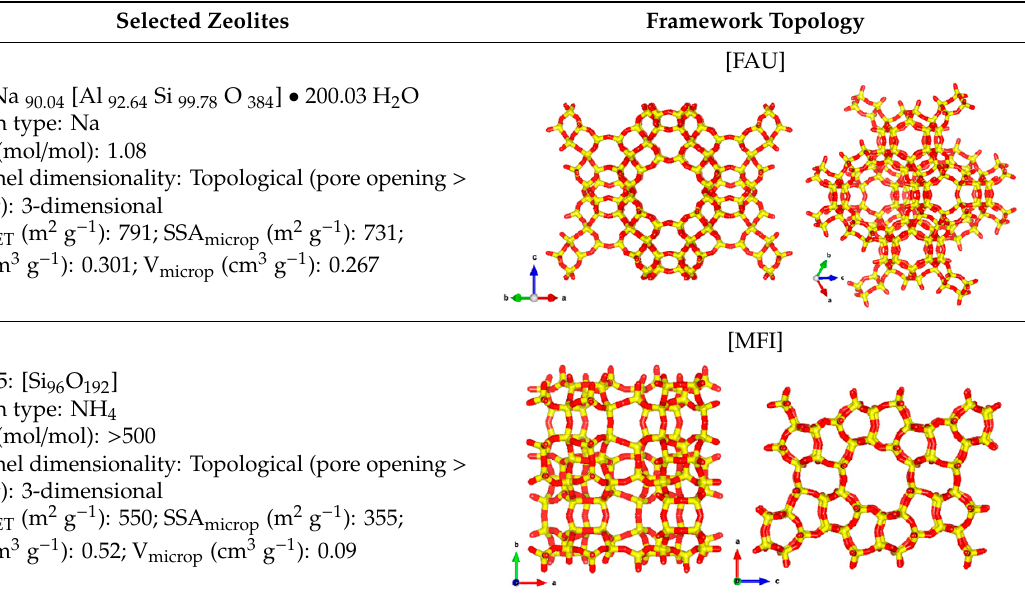
Table 1. Structural and physico-chemical characteristics of zeolites under investigation.